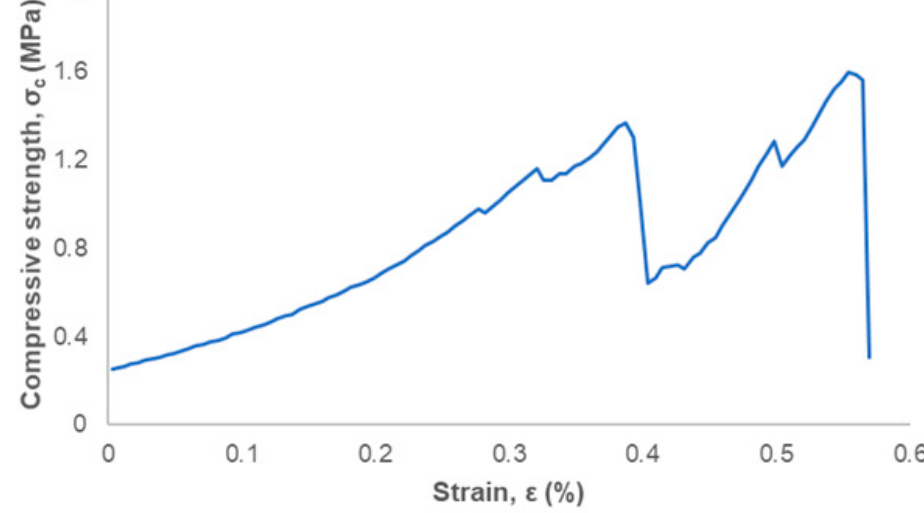
Figure 2. Typical stress–strain curve obtained after compressive test of hydroxyapatite scaffolds.